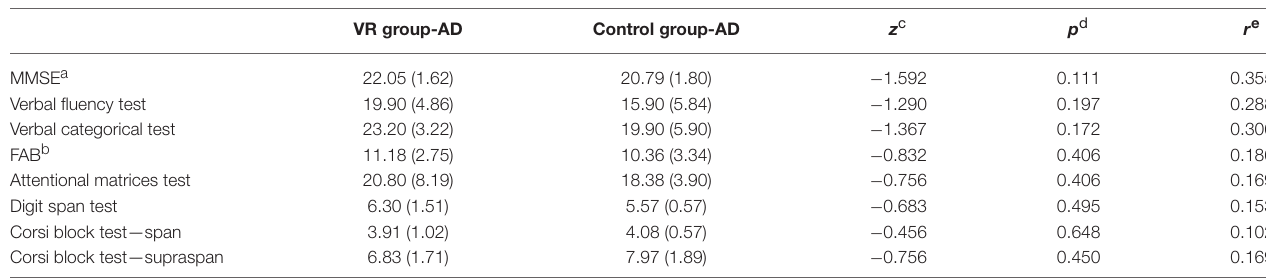
TABLE 2 | Baseline